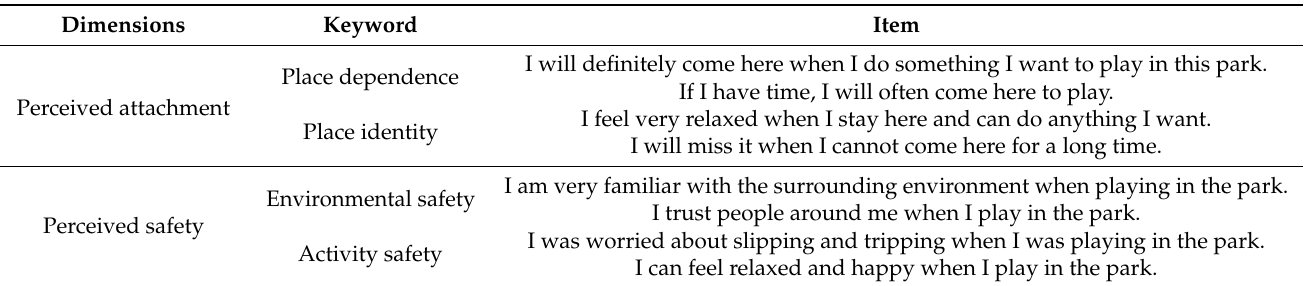
Table 1. Evaluation of children’s perception of social environment in urban parks.